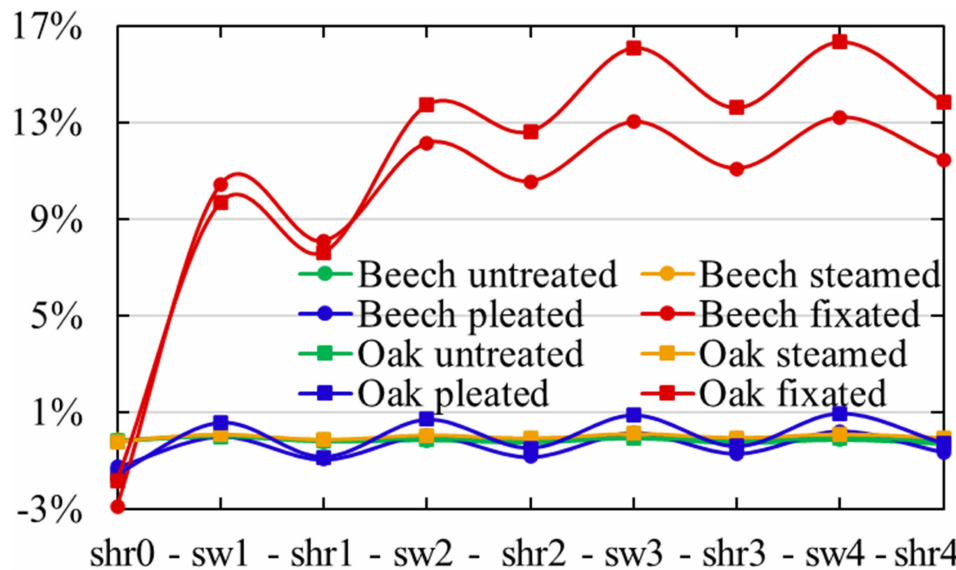
Figure 11. Cumulative plot of shrinkage–swelling values along the grain for the four cycles studied. Reproduced from [59], with permission from B á der, 2023. Abbreviations: shr—shrinkage cycle; sw—swelling cycle. Note: the shrinkage–swelling cycles are numbered; cycle 0 indicates the drying of the green wood samples as defined in the